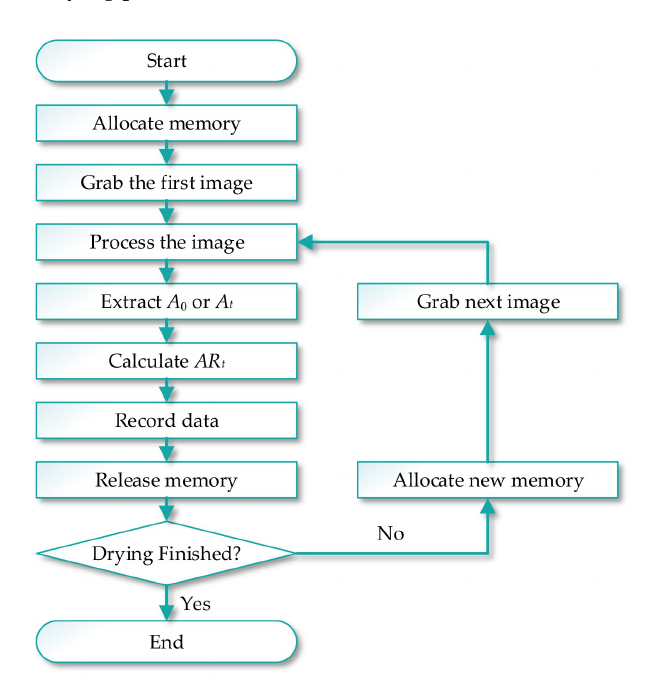
Figure 4. The flowchart of the machine vision part of the